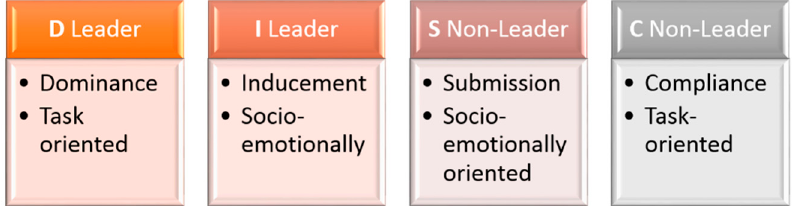
Figure 1. DISC (dominance, inducement / influence, submission / steadiness, compliance tool) personality types (adapted from [11]).